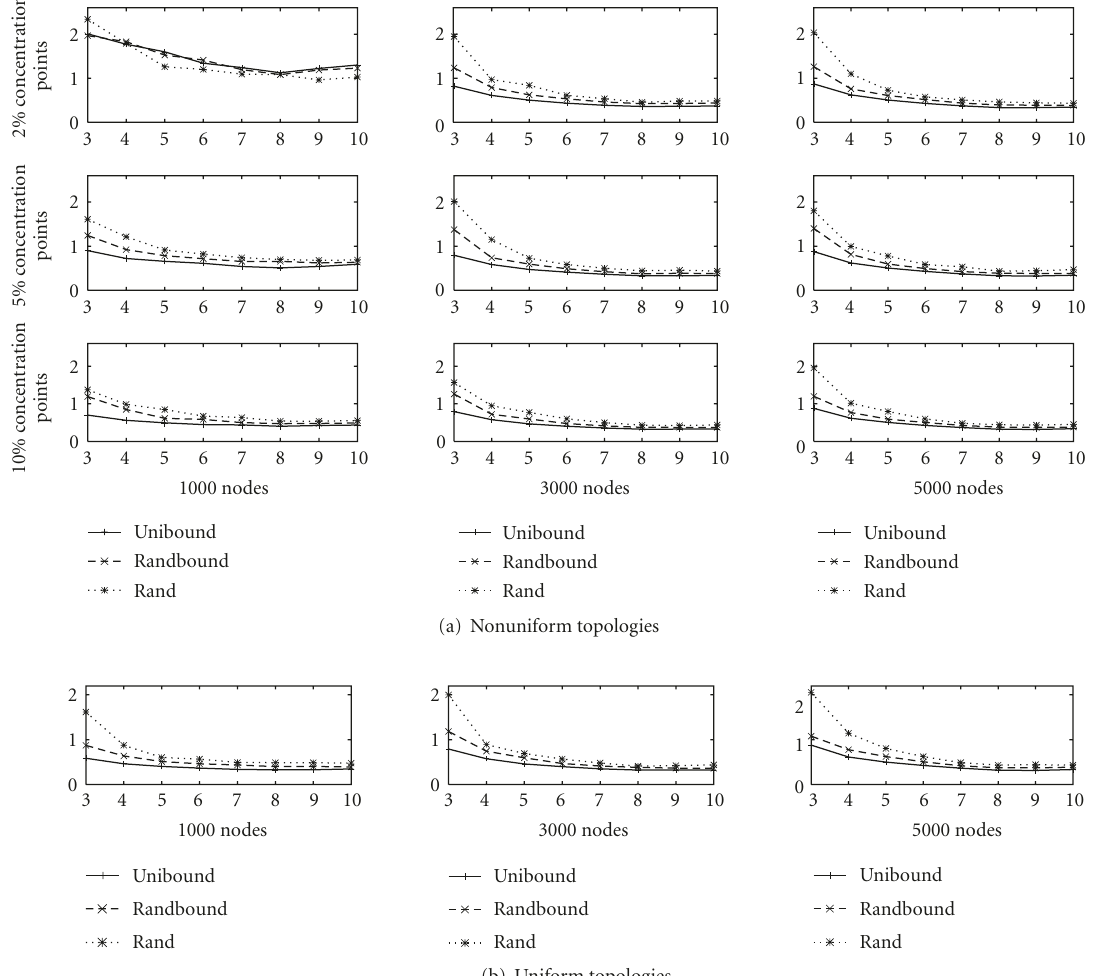
Figure 7: Average zone size in radio range units ( y axis) as a function of number of landmarks ( x axis) for di ff erent landmark placement